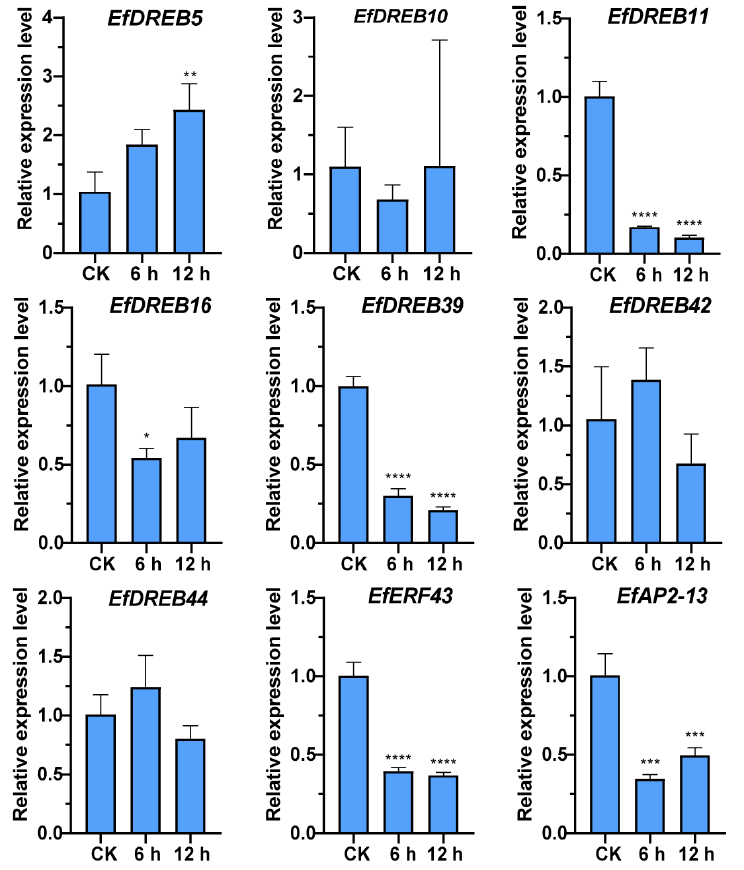
Figure 13. Expression profiles of 9 selected EfAP2/ERF genes in response to ABA treatment. Each column represents the mean of three independent experiments. The error bars represent the standard deviations of the mean. The significant differences relative to controls (one-way ANOVA with Tukey’s multiple range test) are indicated by * p < 0.05, ** p < 0.01, *** p < 0.001, and **** p <